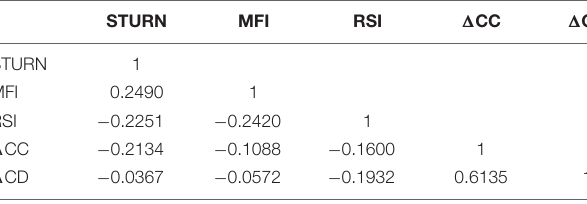
TABLE 9 | Ordinary correlations (United States).